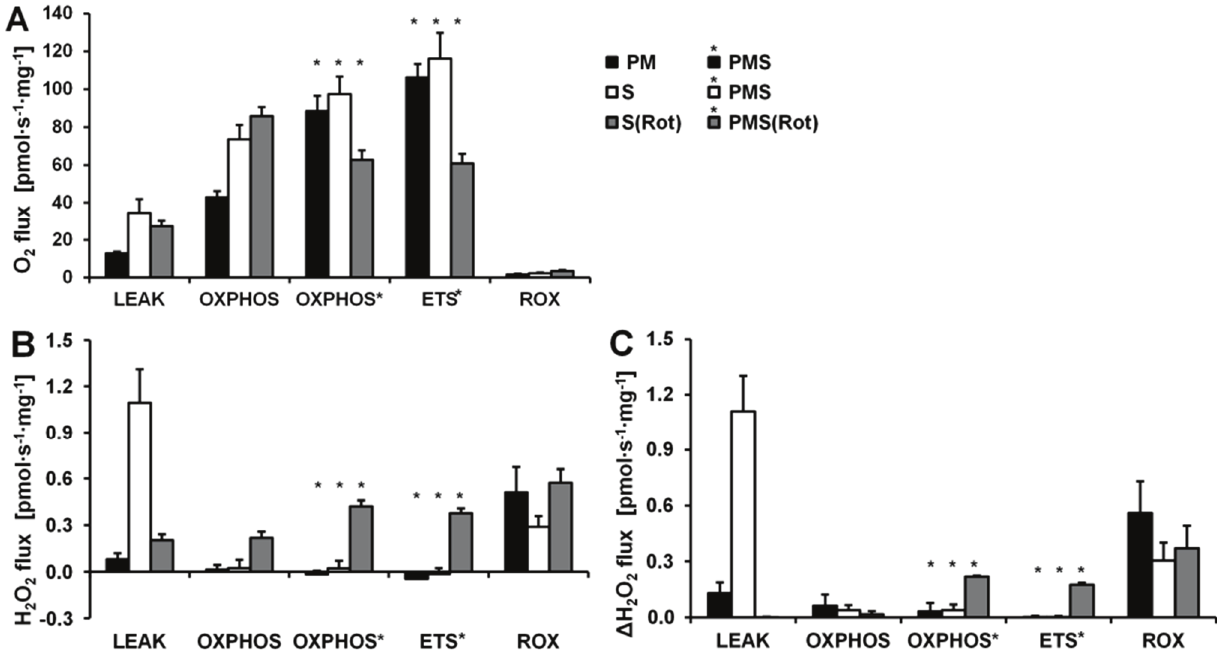
Figure 7. Respiration and H 2 O 2 flux in mouse brain homogenate in SUIT protocols using PM (black bars), S (white bars) and S(Rot) (grey bars) as initial substrates. ( A ) Oxygen flux. ( B ) H 2 O 2 flux corrected for the slope determined in the absence of homogenate; ( C ) H 2 O 2 flux corrected for minimal observed slope. The fluorescence signals were calibrated using the H 2 O 2 titrations at the corresponding state (Figure 6). Bars are means ± SD of 3 animals, each measured in